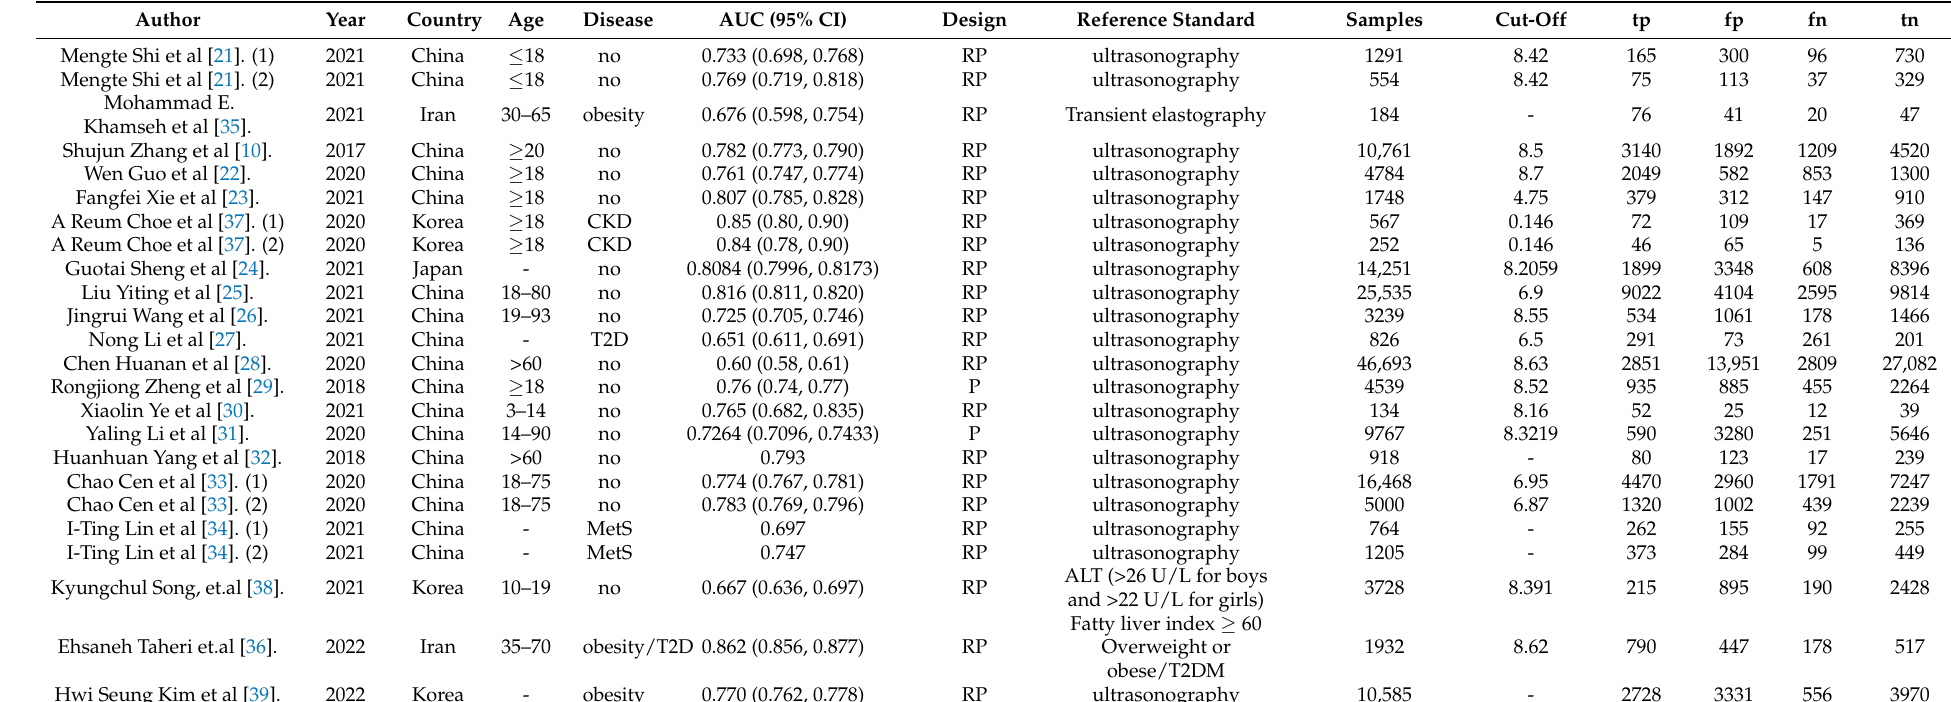
Table 2. Characteristics of Studies Included in the meta-analysis of TyG index in NAFLD/MALFD